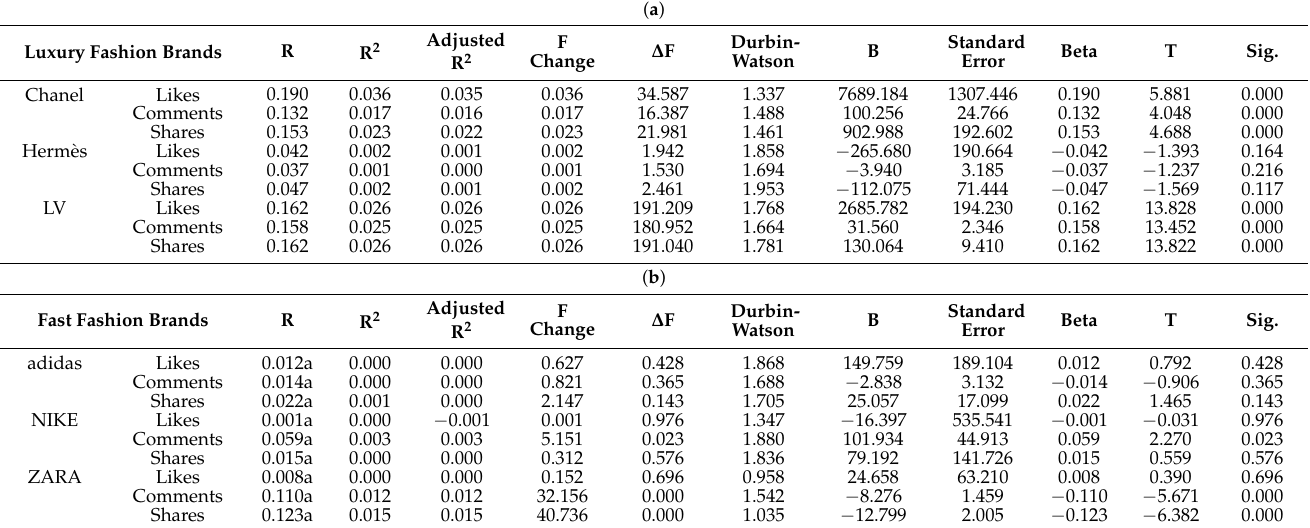
Table 2. ( a ) Linear regression coefficient of determination and beta (luxury fashion brands), ( b ) Linear regression coefficient of determination and beta (fast fashion